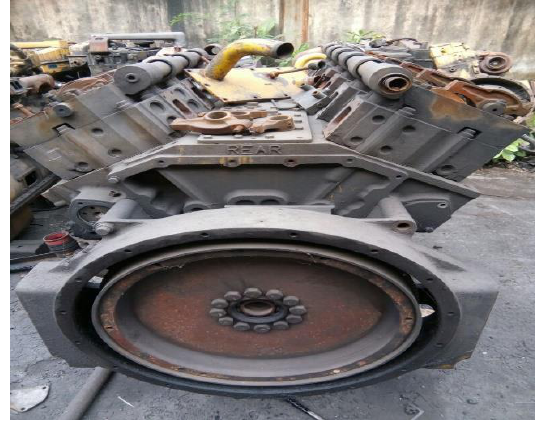
Figure A1. Dumper engine under study. Table A1. Reliability and MTBF for all five subsystems.